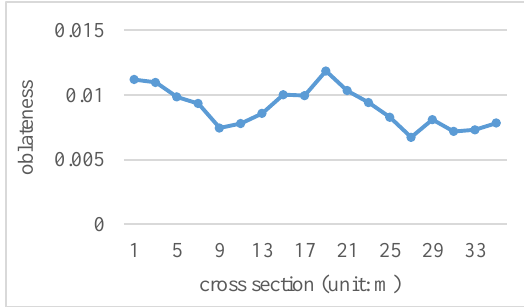
Figure 12 Oblateness of the cross